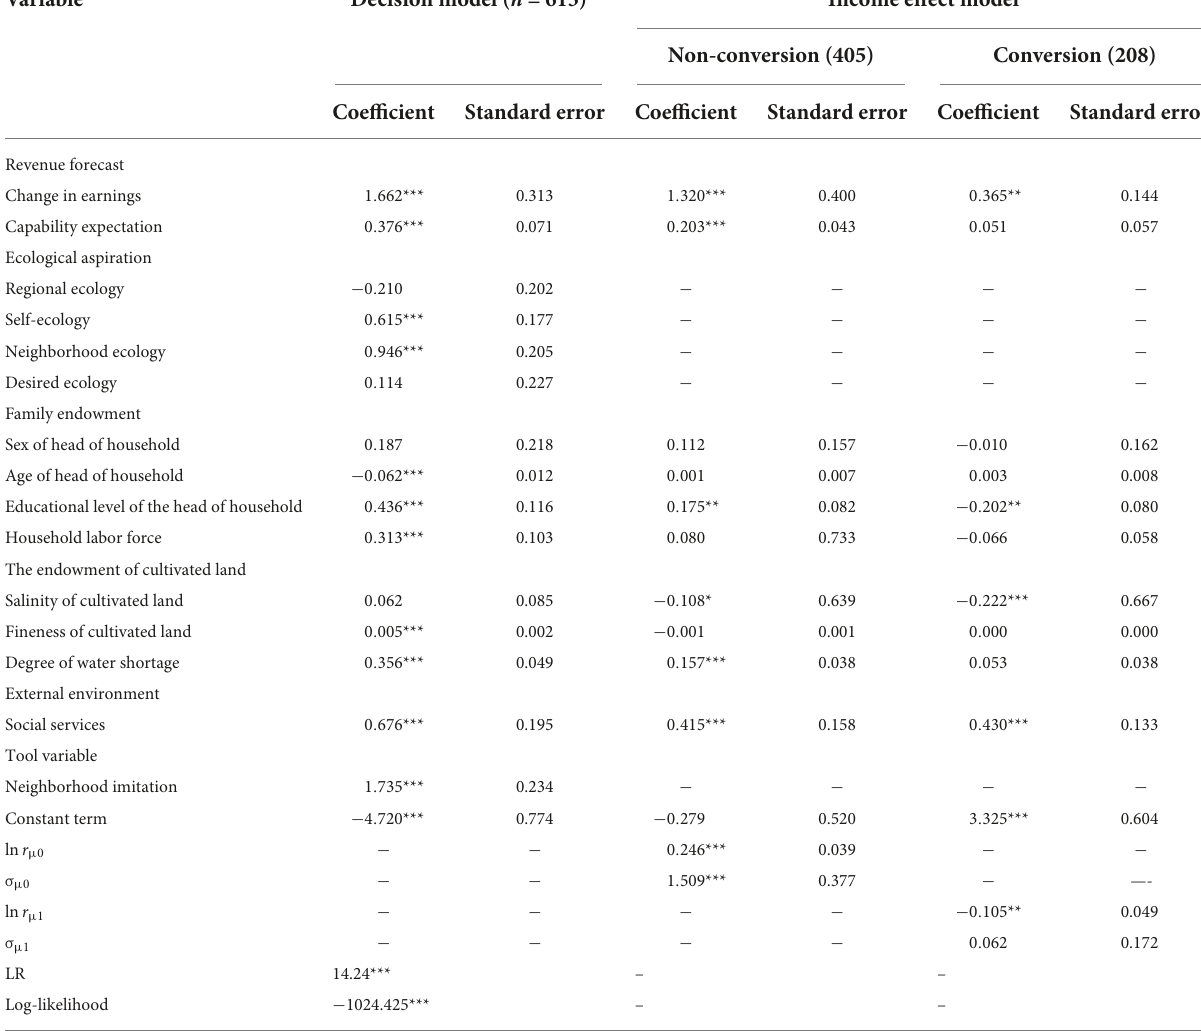
TABLE 3 Results of simultaneous estimation of decision-making model and income effect of G.G.P. for